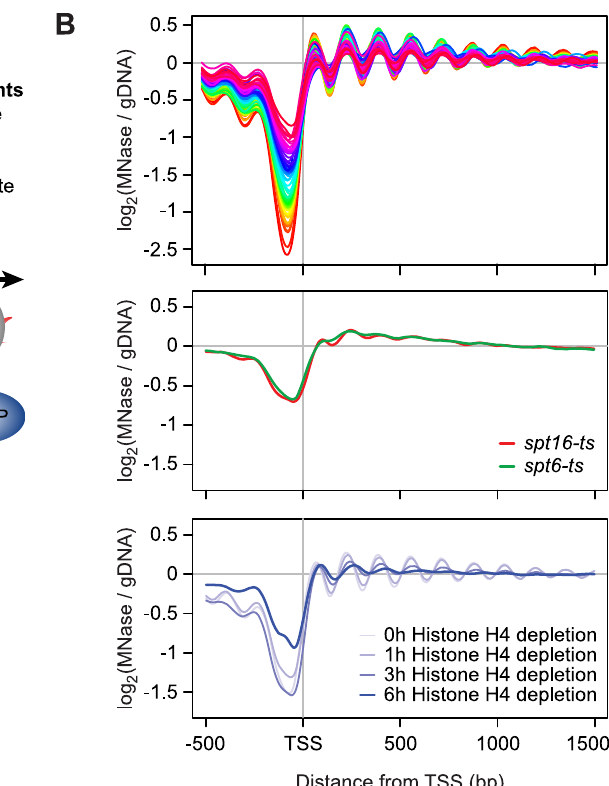
Figure 1. Global nucleosome occupancy profiles. A) Schematic overview of compendium mutants and conditions. B) Average nucleosome occupancy relative to the curated transcription start sites of 5,043 S. cerevisiae genes, expressed as the log2 ratio of probe intensities of MNase- treated nucleosomal DNA samples over un-crosslinked DNA samples. 52 mutants and conditions with a canonical nucleosome distribution are shown in the top panel and differentially colored according to average NDR occupancy. Mutants with disrupted global nucleosome occupancy profiles are shown below.